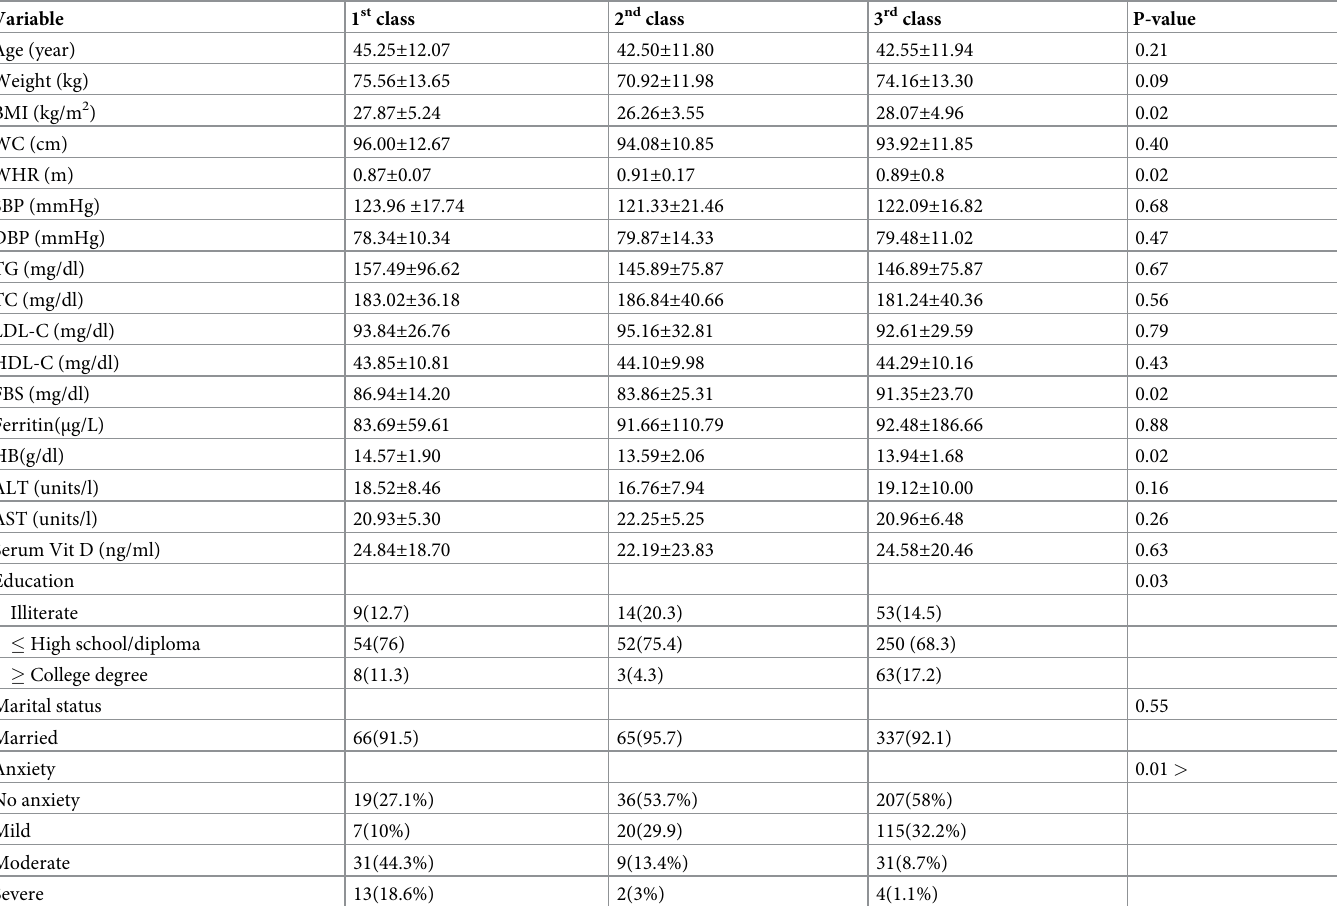
Table 6. Anthropometric, biochemical and demographic parameters according to three latent